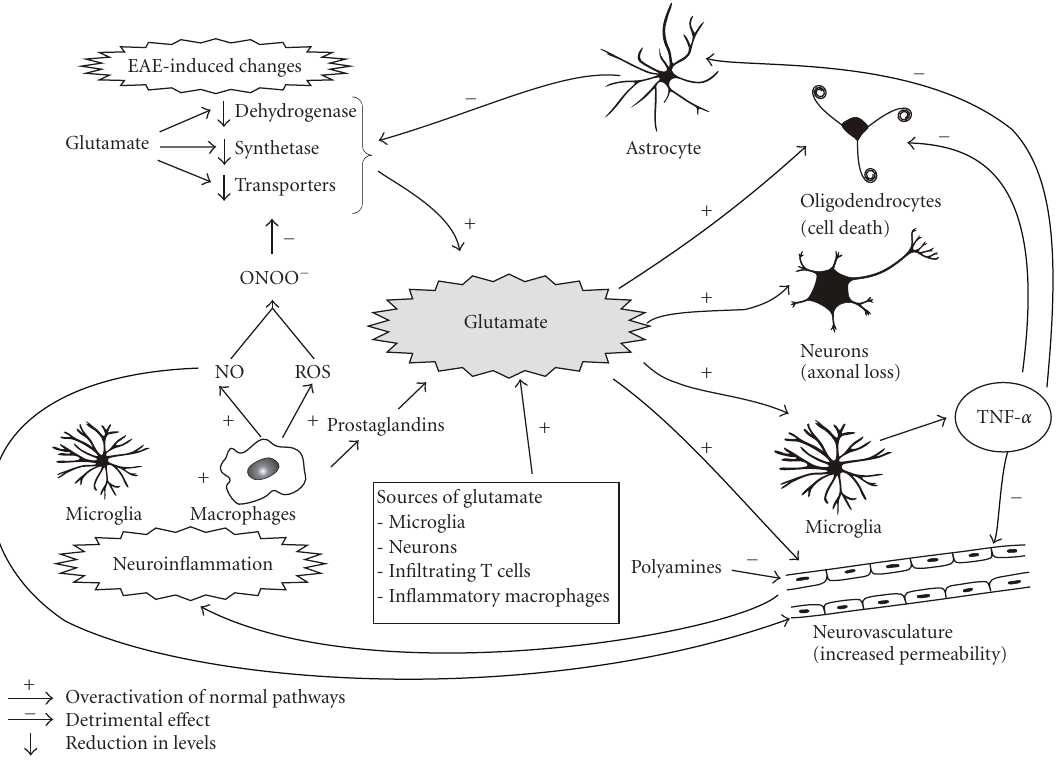
Figure 5: Schematic diagram summarising the known and proposed role of glutamate and associated relevant mediators in the development of neuroinflammatory and neurodegenerative pathology during EAE. Abbreviations: EAE, experimental autoimmune encephalomyelitis; NO, nitric oxide; ONOO − , peroxynitrite; ROS, reactive oxygen species; TNF- α , tumour necrosis factor